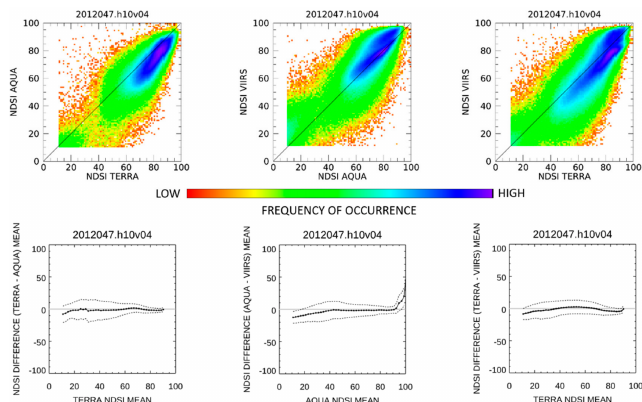
Figure 9. Cross-comparisons of 16 February 2012 for tile h10v04. MOD10A1 to MYD10A1 ( left ), MYD10A1 to VNP10A1 ( center ) and MOD10A1 to VNP10A1 ( right ). 2D histograms of cell-to-cell NDSI_Snow_Cover comparisons in the top row. NDSI_Snow_Cover mean di ff erences in the bottom row; mean is solid line and standard deviation is dashed line.